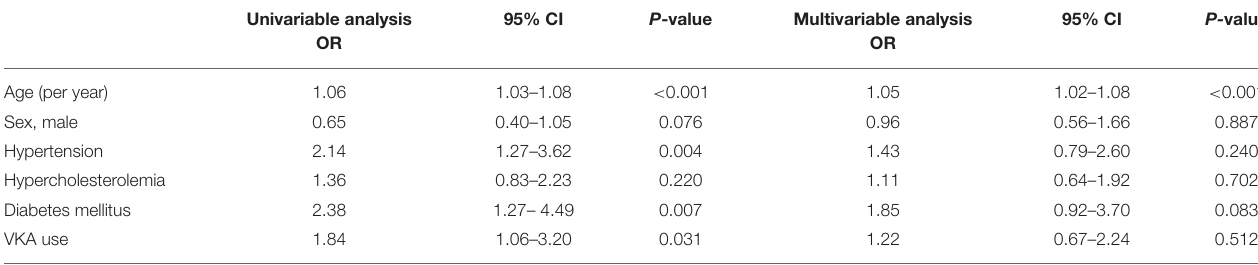
TABLE 2 | Univariable and multivariable logistic regression analysis for variables associated with